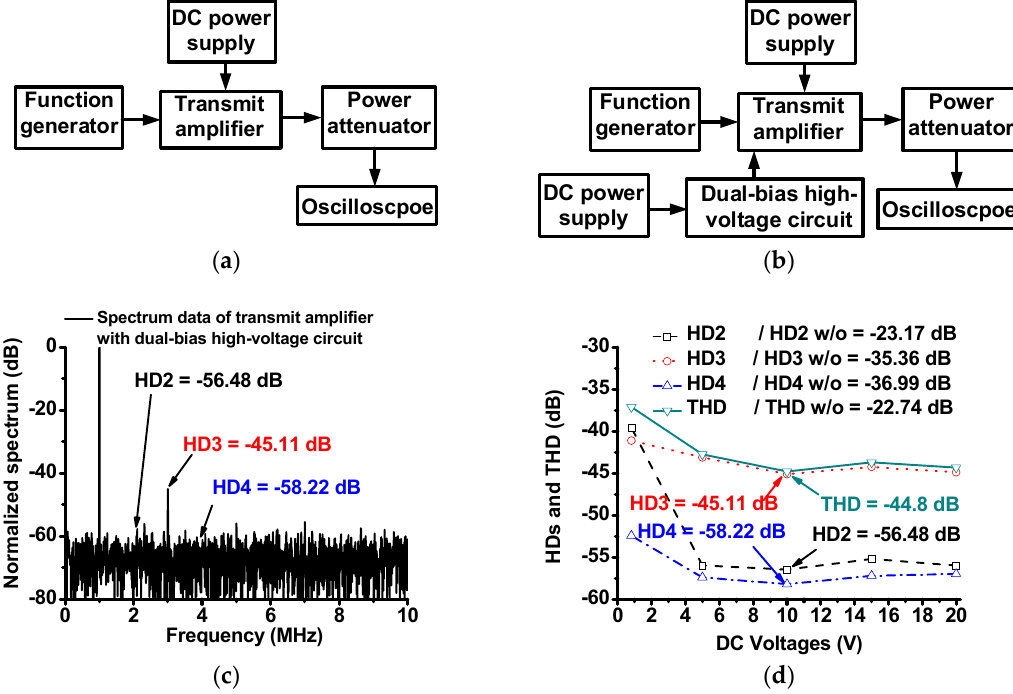
Figure 6. Block diagram of measurement system when using ( a ) transmit amplifier only and ( b ) transmit amplifier with dual-bias high-voltage circuit, ( c ) spectrum data of transmit amplifier with dual-bias high-voltage circuit at 10 V DC voltage, and ( d ) HD2, HD3, HD4 and THD values with and without dual-bias high-voltage circuit vs. 0.8 V, 5 V, 10 V, 15 V and 20 V DC voltages (graph with dash, dot, dash-dot and solid marks represent HD2, HD3, HD4, and THD, respectively, of the transmit amplifier with dual-bias high-voltage circuit). HD2 w/o, HD3 w/o, HD4 w/o, THD w/o represent the measured HD2, HD3, HD4, and THD of the output signals, respectively, when using transmit amplifier only.